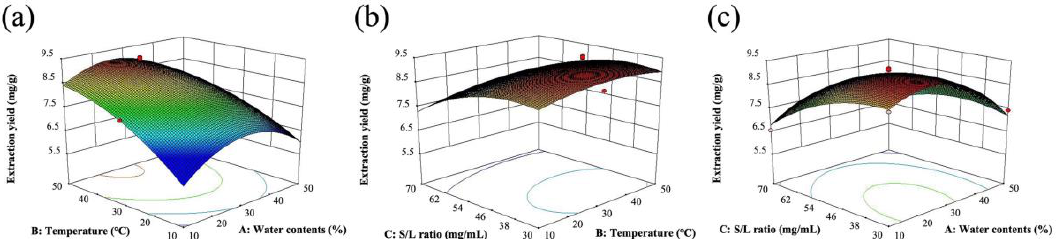
Figure 3. Response surfaces of total flavonoid content (TFC) for optimization: ( a ) deep eutectic solvent (DES) water content, ( b ) extraction temperature, and ( c ) solid–liquid ratio.